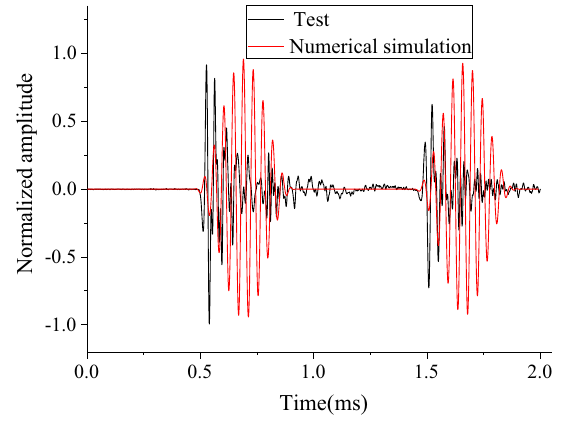
Fig. 11 Comparison of numerical and test results of wave propaga- tion in free